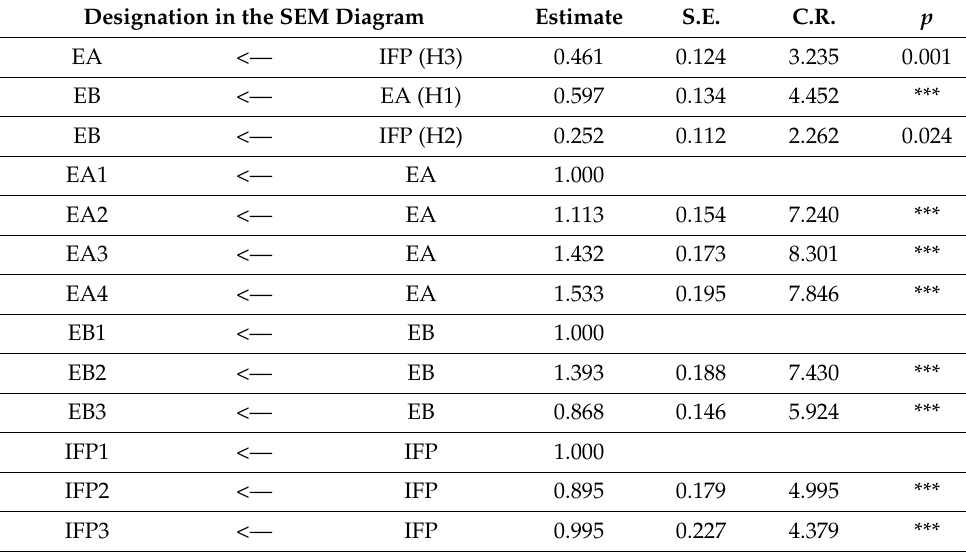
Table 3. Regression weights in the model (unstandardized estimates).